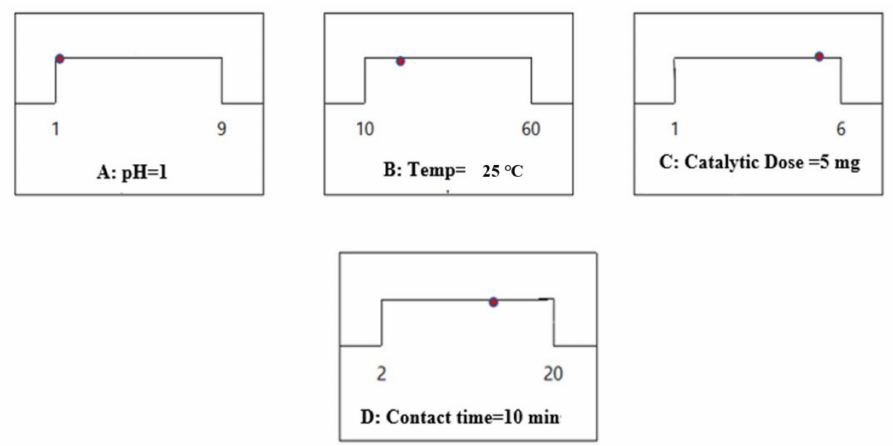
Figure 9. The Box-Behnken statistical method to create optimal conditions of pH, temperature, catalytic dose and contact time.